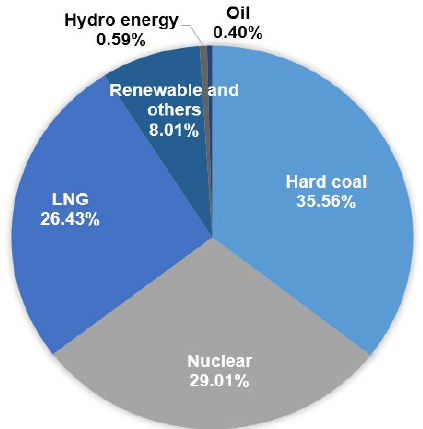
Figure 8. Energy source fractions of electricity in the Republic of Korea